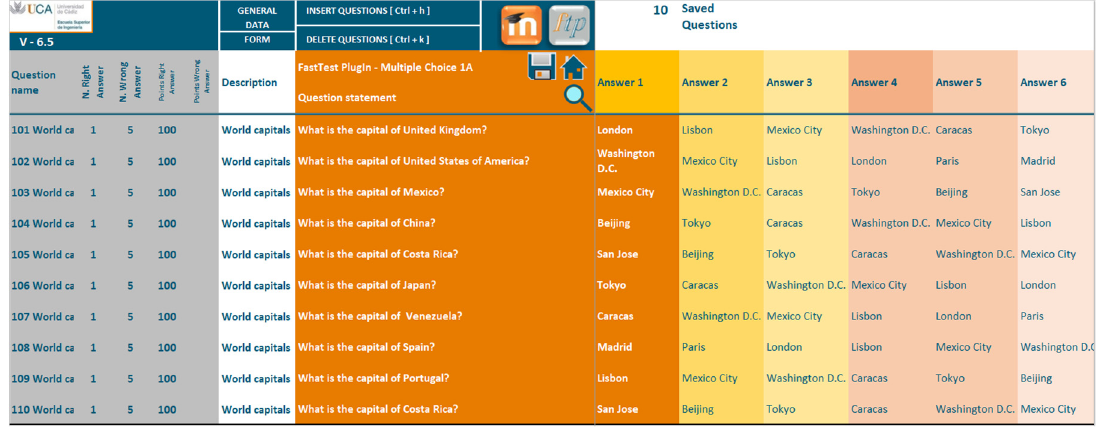
Figure 6. Example: saving 10 parameterised questions.